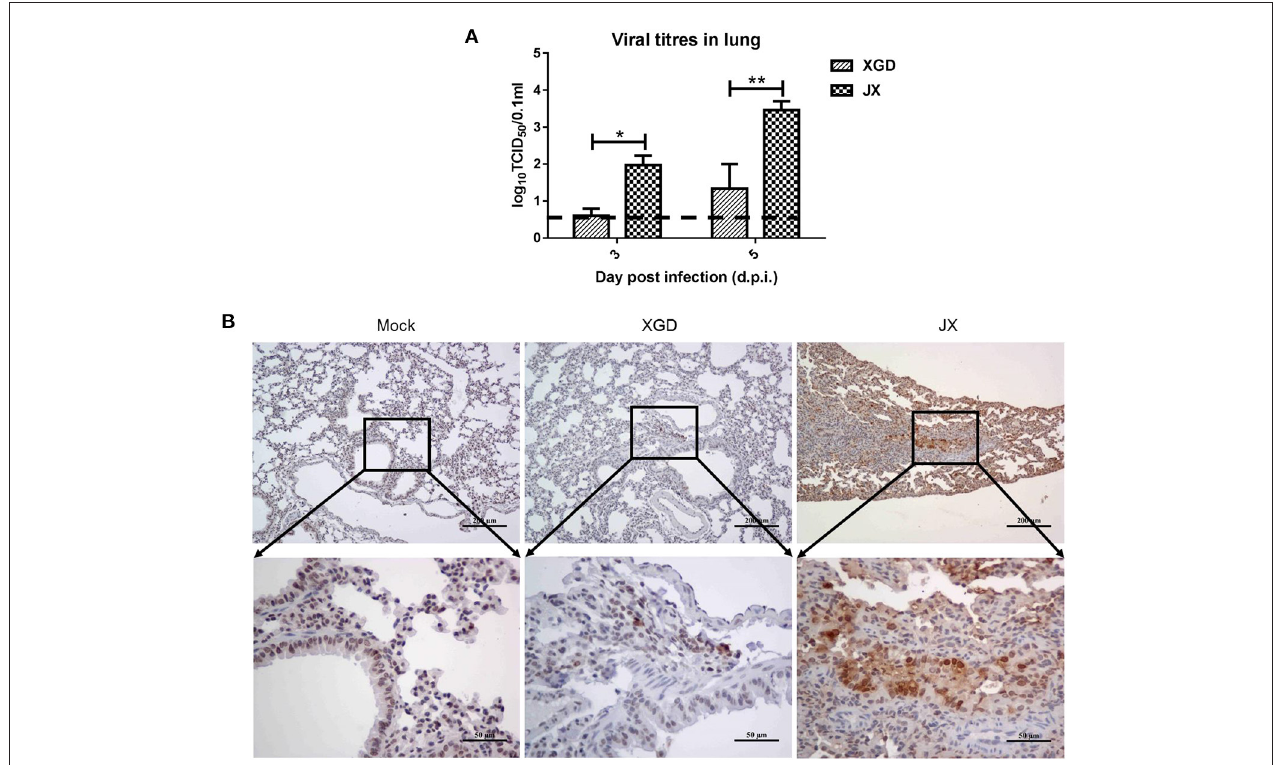
FIGURE 5 | Viral loads and immunohistochemistry analysis of the lungs of mice infected with the XGD and JX strains of H5N6. Groups of mice ( n = 6) were intranasally infected with 10 5 TCID 50 of XGD or JX. Control mice were inoculated with phosphate-buffered saline (PBS). Lungs were collected at 3 and 5 days post-infection (dpi). (A) XGD and JX titers in mouse lungs were calculated through TCID 50 at 3 days post-infection (dpi) and 5 dpi. (B) Immunohistochemical detection of Nucleoprotein (NP) antigen in mouse lungs at 5 dpi. Scale bar in (B): the three images on the top, 200 µ m; the three images at bottom: 50 µ